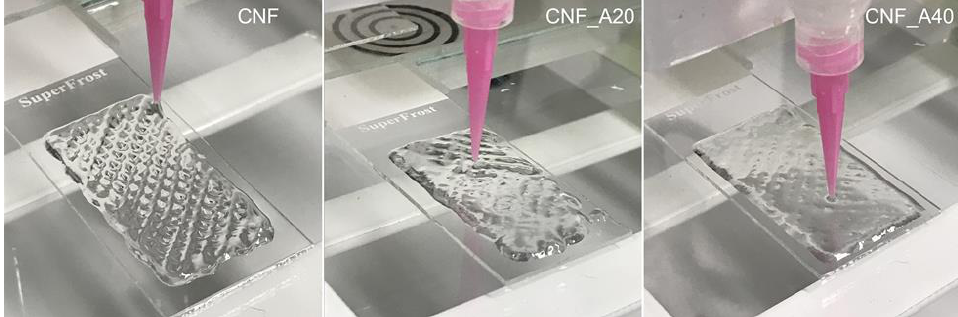
Figure 2. 3D printed gels. Note the relatively large lateral flow of inks CNF_A20 and CNF_A40. The target dimensions of the 3D printed structures were 20 mm × 40 mm.